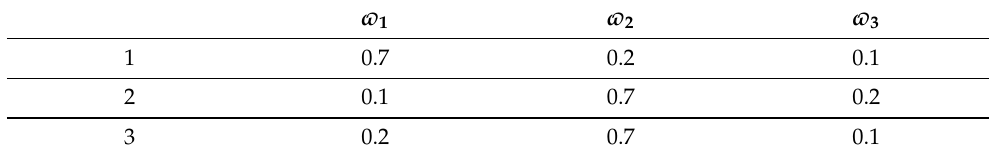
Table 1. Selected values for the